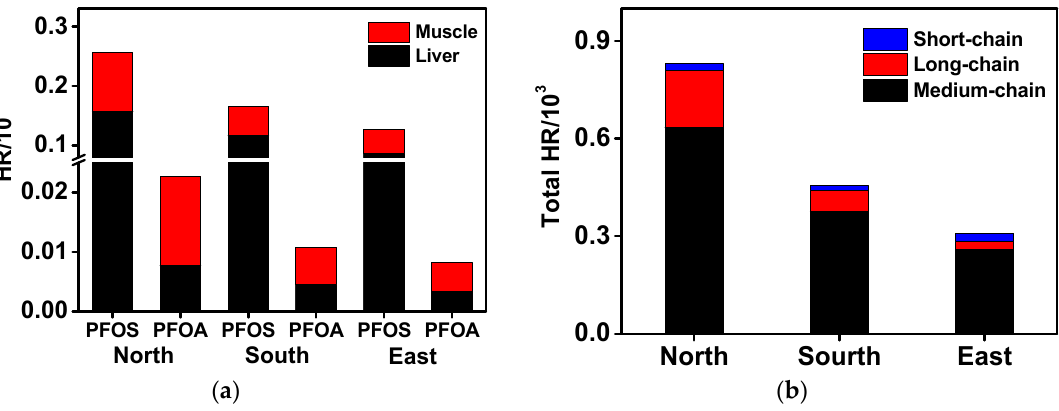
Figure 7. Hazard ratios of PFOA, PFOS, and ∑ PFAAs in three parts of Xinjiang. ( a ) Contribution of muscle and liver to PFOS/PFOA exposure; ( b ) Contribution of different chain lengths of PFAAs to total PFAAs exposure.